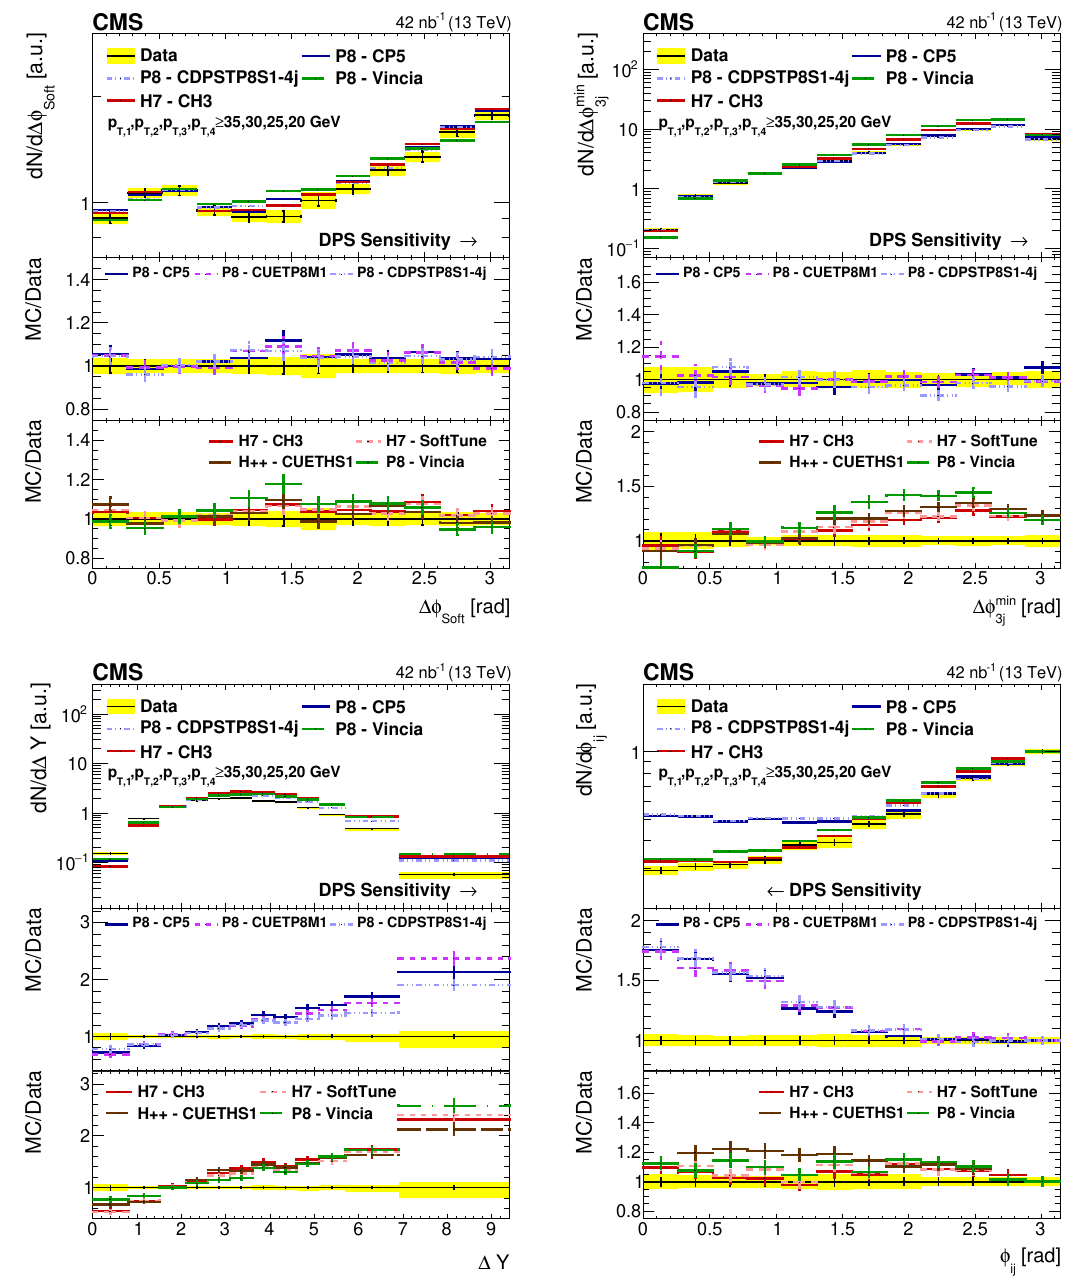
, ∆ φ min , ∆ Y , and φ distributions from data to different Figure 4 . Comparison of the ∆ φ Soft 3j ij pythia 8 (P8), herwig++ (H++), and herwig 7 (H7) tunes in Region I. All distributions have been normalized to regions where a reduced DPS contribution is expected. The error bars represent the statistical uncertainty, and the yellow band indicates the total (statistical+systematic)